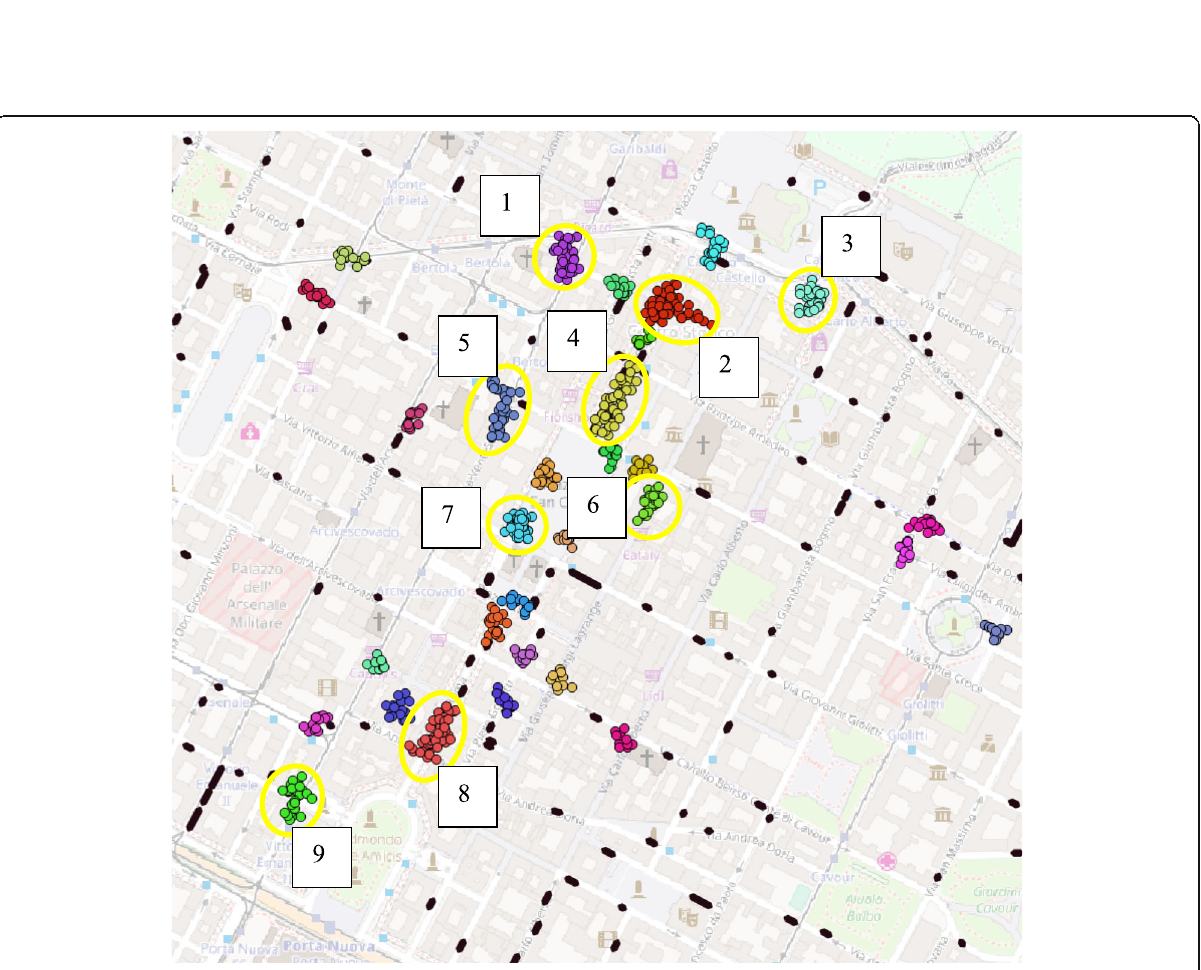
Fig. 4 Clusters with at least 10 stops (colored dots), clusters with at least 20 stops (yellow ovals) and designated load/unload areas (black